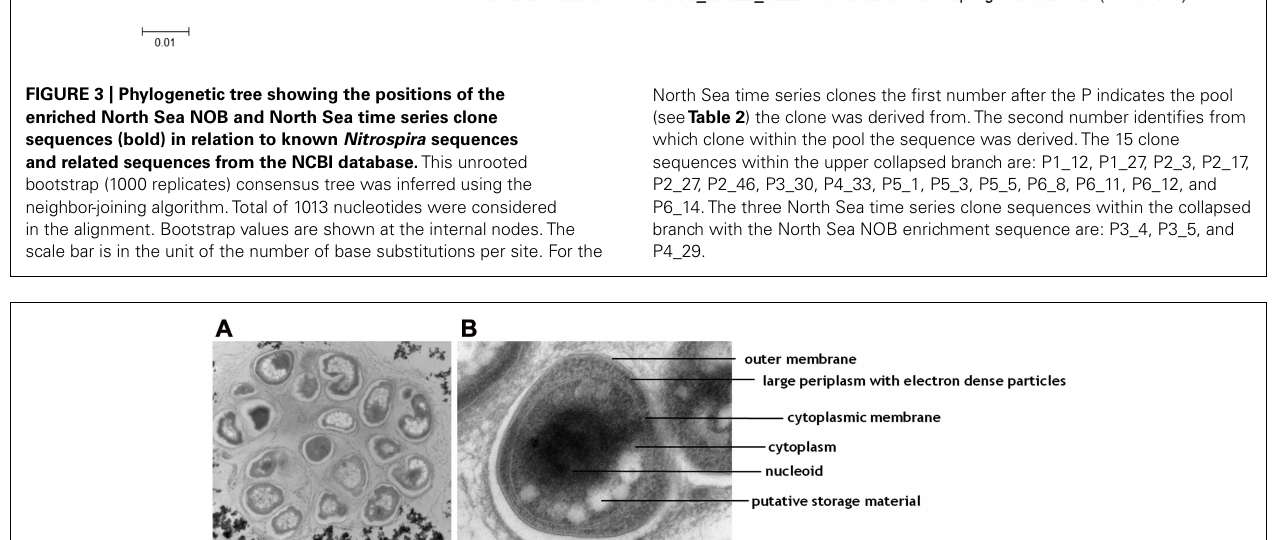
North Sea time series clones the first number after the P indicates the pool (see Table 2 ) the clone was derived from.The second number identifies from which clone within the pool the sequence was derived.The 15 clone sequences within the upper collapsed branch are: P1_12, P1_27, P2_3, P2_17,